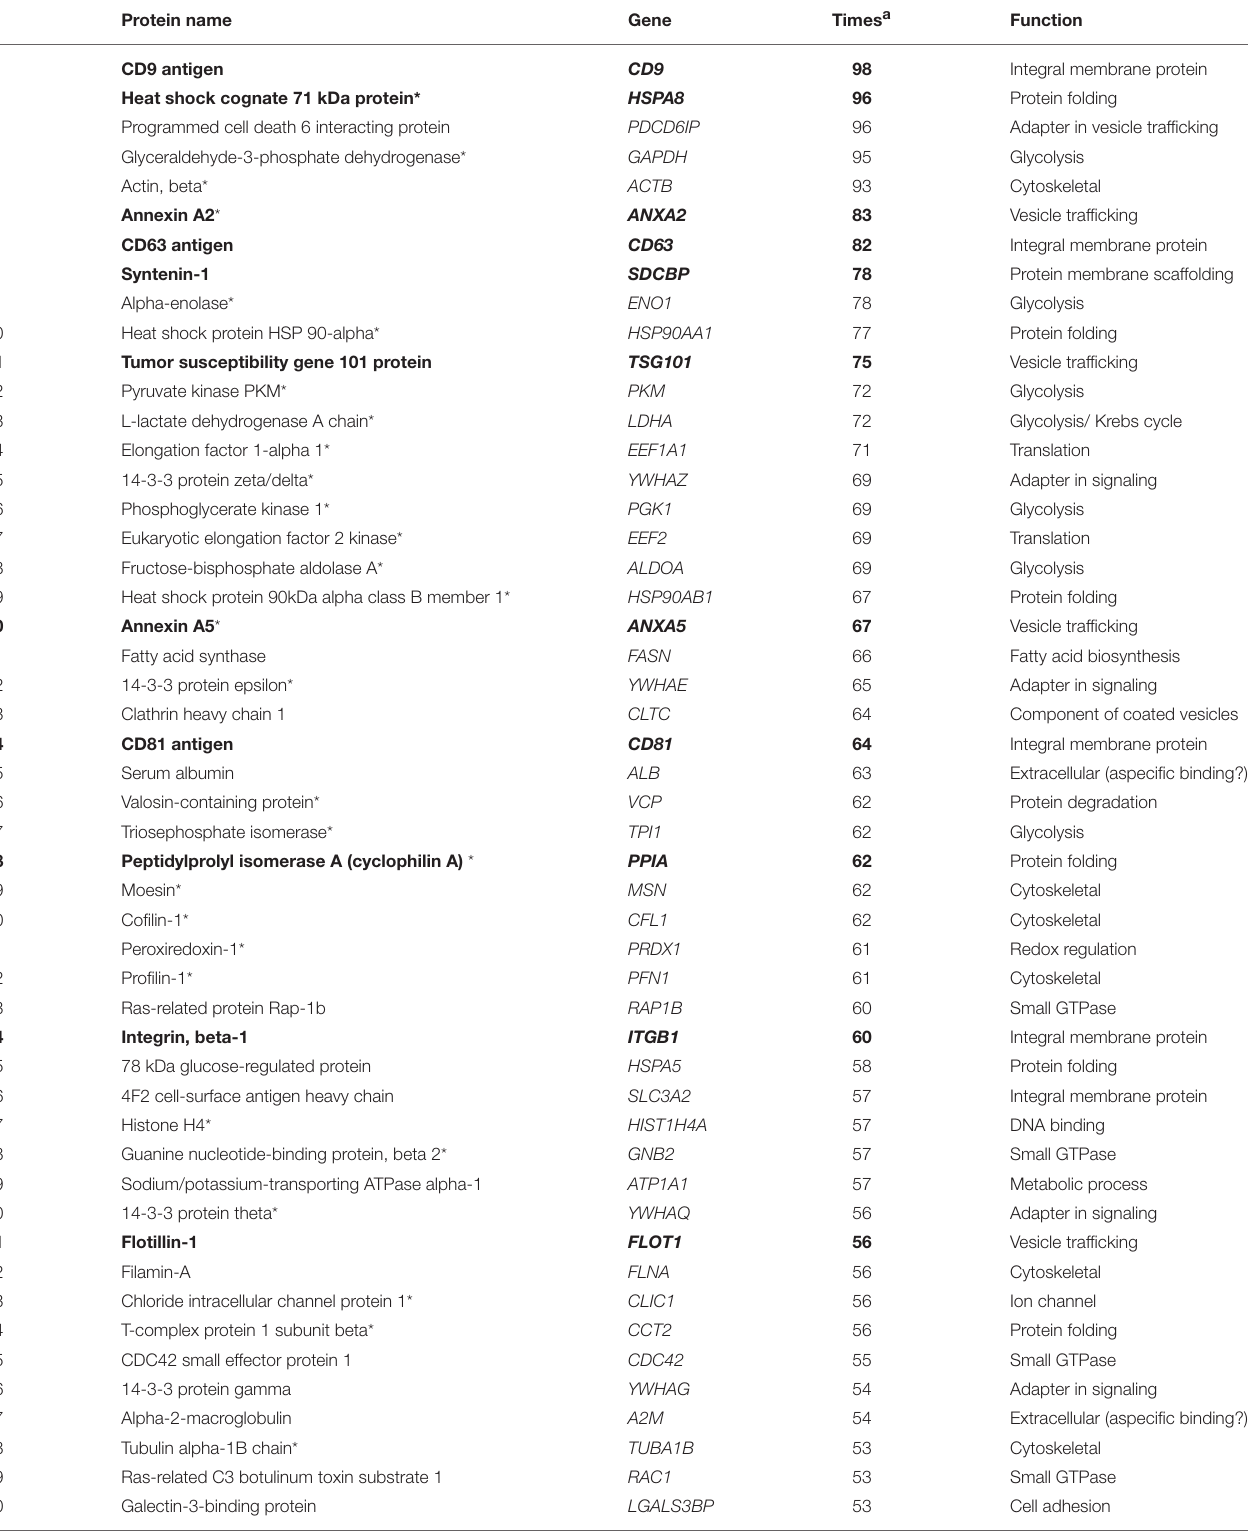
TABLE 2 | List of the top 50 most commonly identified proteins in exosome